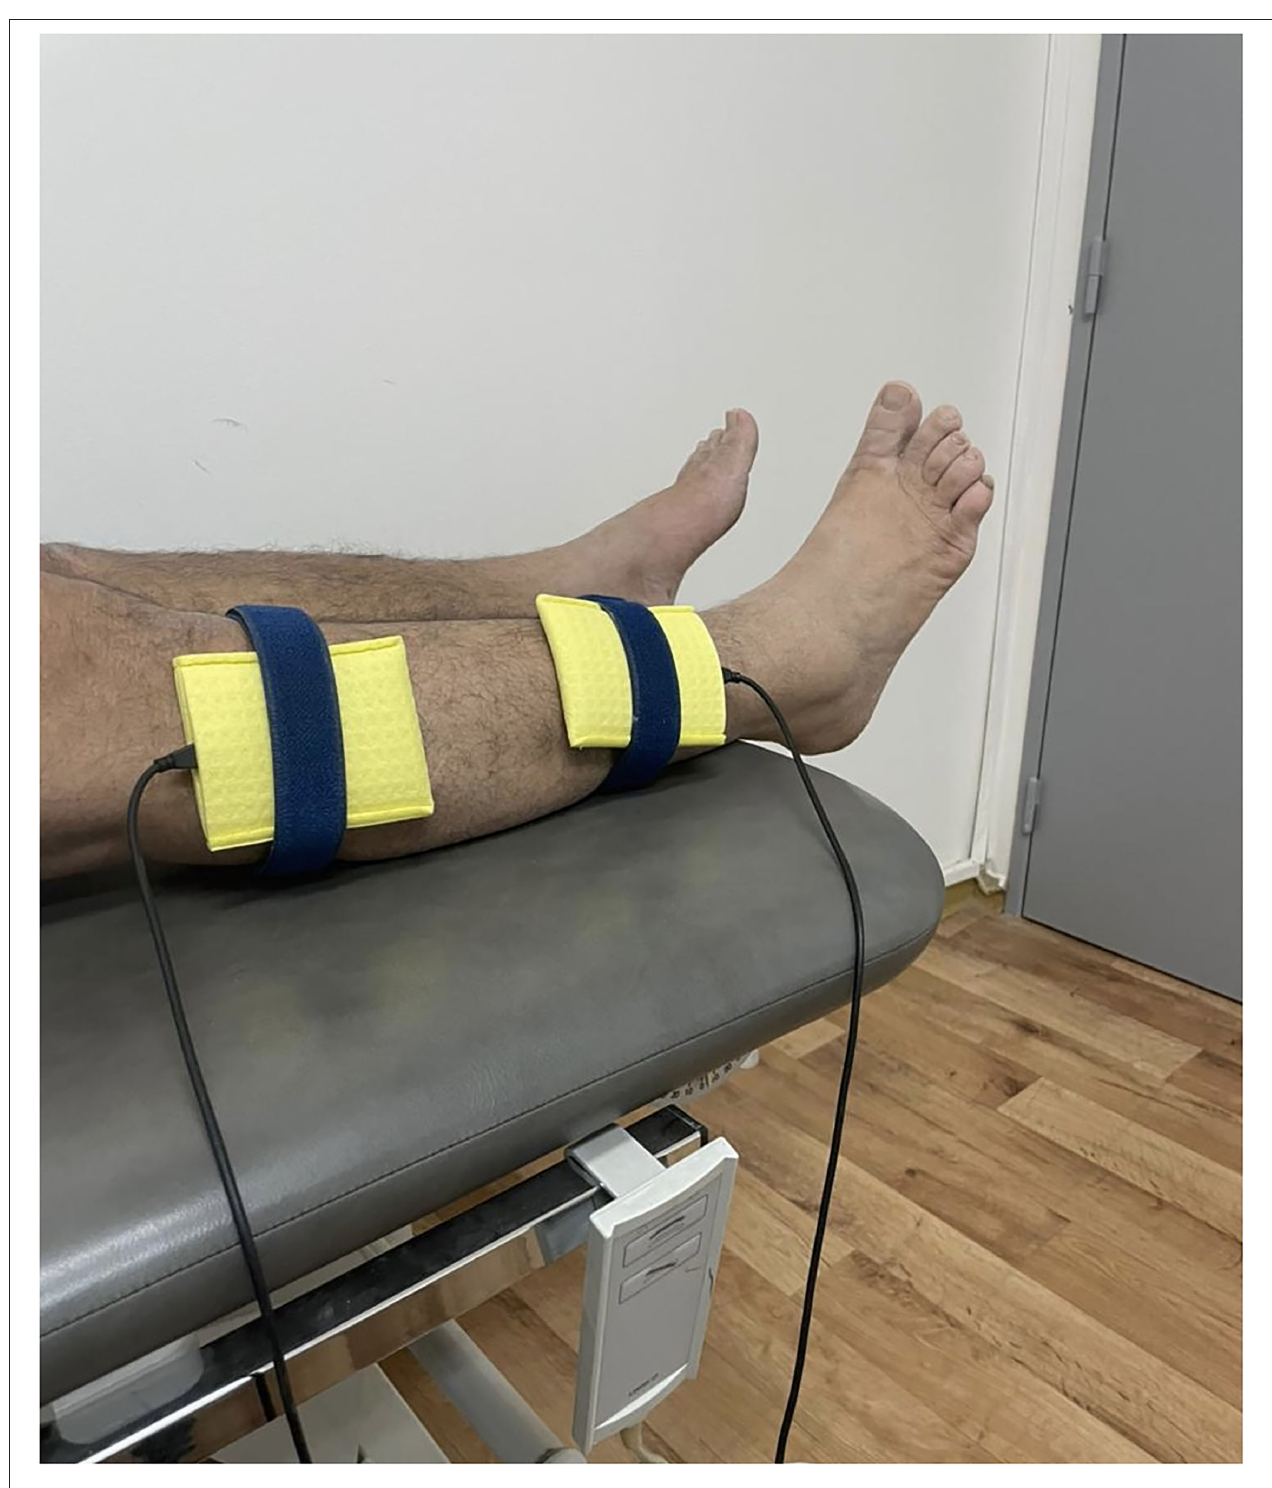
FIGURE 2 | The placement of electrodes on the dorsiflexor muscles of patient with hemiplegia.